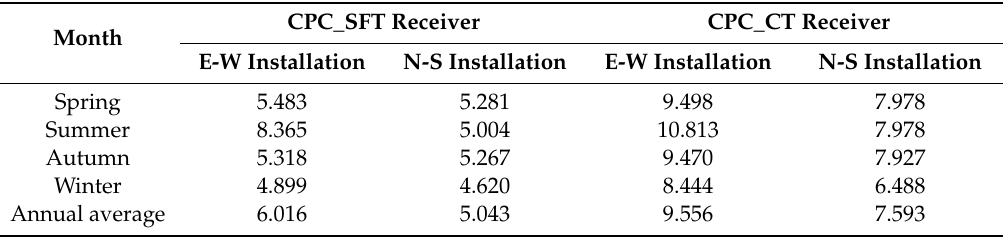
Table 4. Daily optical energy collection (in MJ) by truncated CPC coupled with SFT and CT receivers under different configurations.